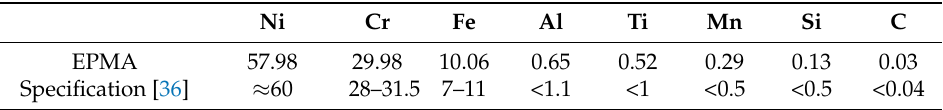
Table 1. Composition of alloy filler metal 52 (FM52) in weight